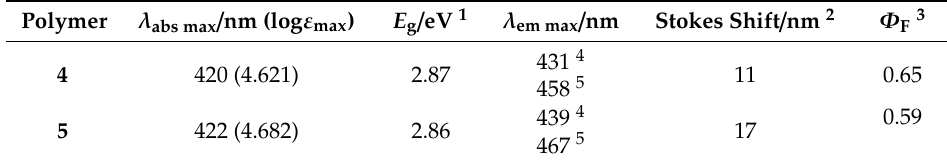
Table 2. Photophysical properties of polymers 4 and 5 in CHCl 3